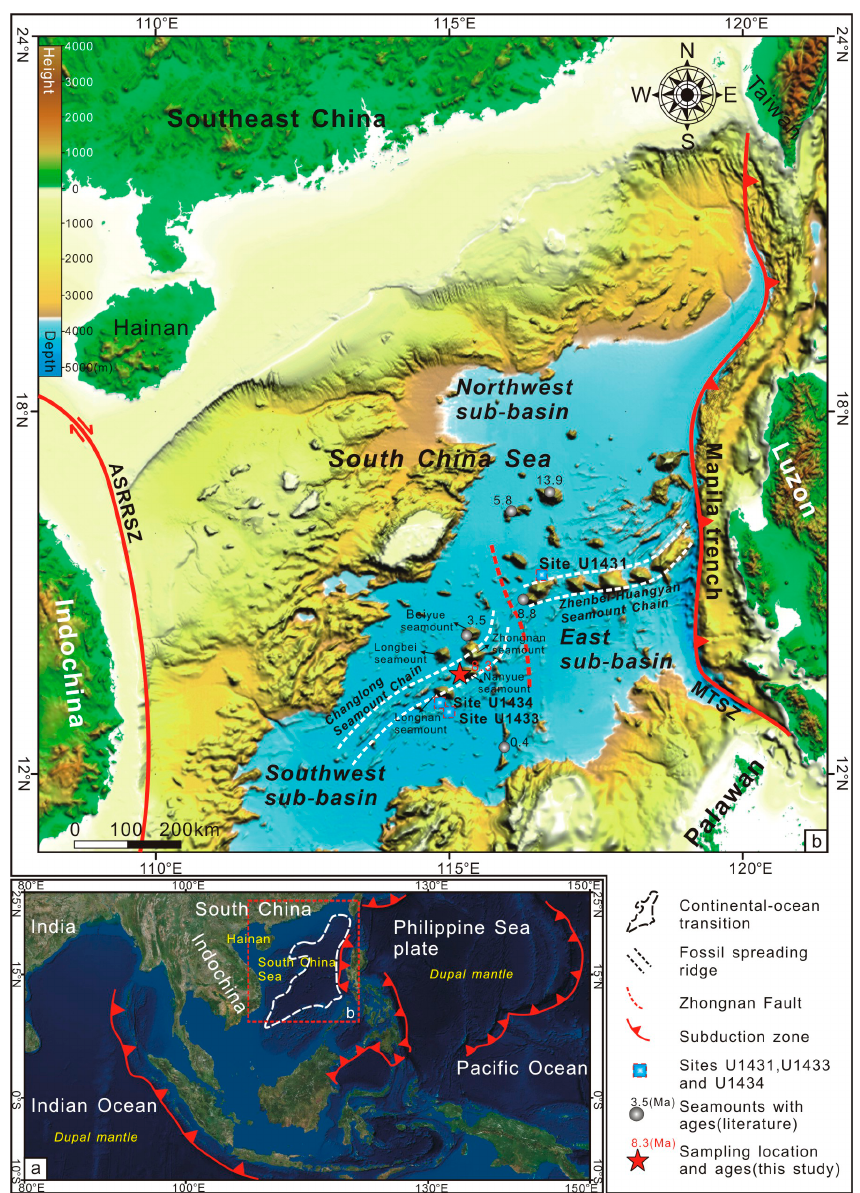
Figure 1. ( a ) Schematic tectonic framework of the southwestern Pacific basins showing major tectonic subdivisions (modified after [5]); ( b ) Geomorphological-bathymetric map illustrating the South China Sea (SCS) area (modified after [19]). Gray dots represent previously dated seamounts [20]. Blue squares represent the International Ocean Discovery Program (IODP) Sites U1433 and U1434 [5]. The location of the Nanyue seamount is also marked by a red asterisk. Abbreviations (in alphabetical order): ASRRSZ = Ailao Shan-Red River Shear Zone; MTSZ = Mariana Trench Subduction Zone.